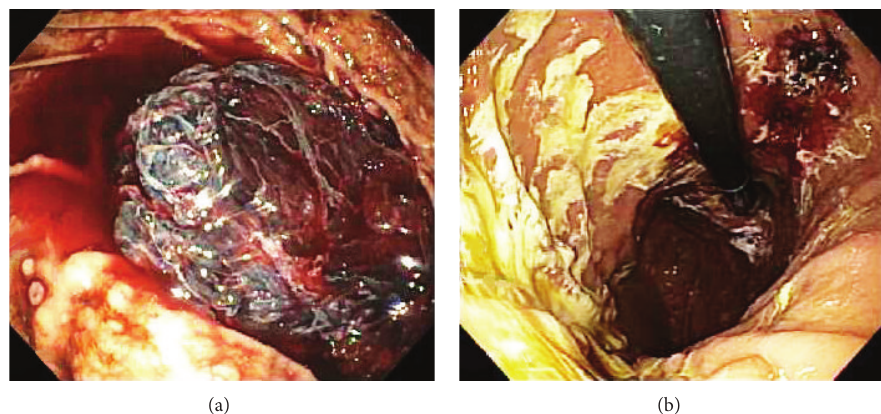
Figure 1: Initial EGD performed for an acute episode of melena in a 92-year-old woman with smoldering multiple myeloma (SMM) revealed a well-organized, hemispherical, 11 × 6 cm tightly adherent clot attached to the midgastric body that that could not be detached despite vigorous endoscopic irrigation and aspiration (a). About eight, 3–5 mm wide sessile polyps (nodules) were present in the gastric fundus and body, devoid of stigmata of recent hemorrhage, two of which were present at the 8 o’clock position. Repeat EGD performed one day later revealed that the clot had mostly dissolved exposing a 2.5 × 2cm ulcerated mass, mostly covered by a clot in the midgastric body along the lesser curvature